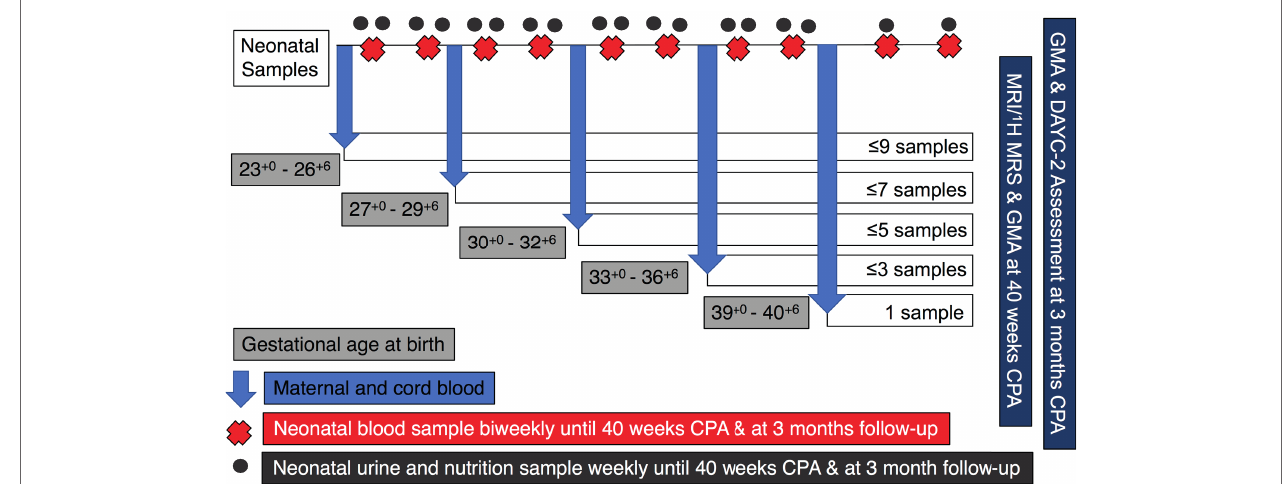
FIGURE 1 | Schematic representation of UNICORN sampling regime. Samples of neonatal blood, urine, and nutrition will be collected weekly or bi-weekly for the duration of the infants stay in hospital. Magnetic resonance imaging (MRI) and magnetic resonance spectroscopy ( 1 H-MRS) will be performed at term corrected postnatal age (CPA). Infants will also undergo a general movements assessment (GMA) at CPA and at 3 months CPA. At the follow-up appointment at 3 months CPA, further neurological assessment will be completed using the Developmental Assessment of Young Children – Second Edition (DAYC-2) assessment